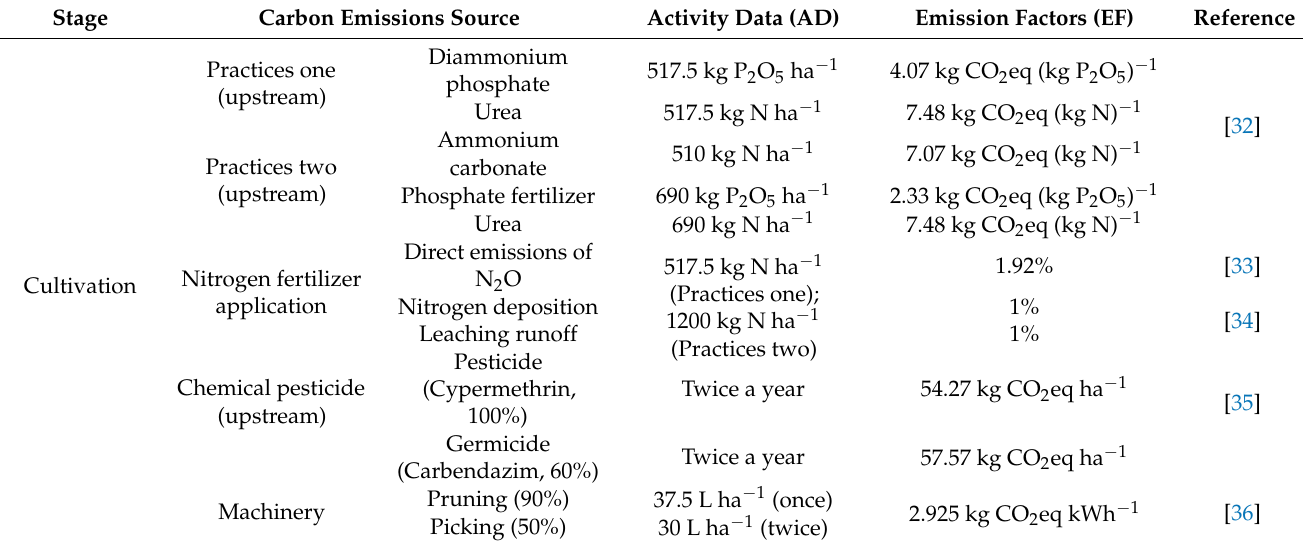
Table 1. Inputs and energy consumption data at the cultivation